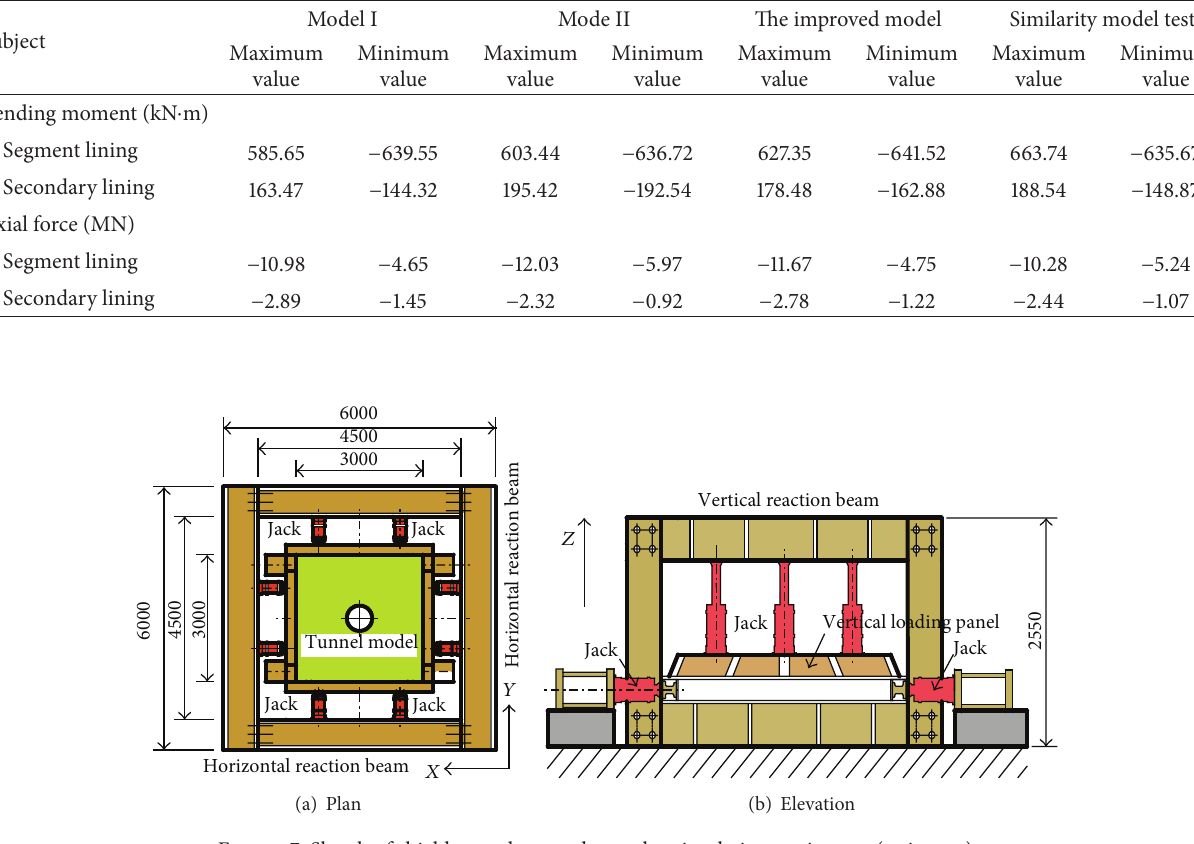
Figure 7: Sketch of shield tunnel-ground complex simulation equipment (unit:mm).